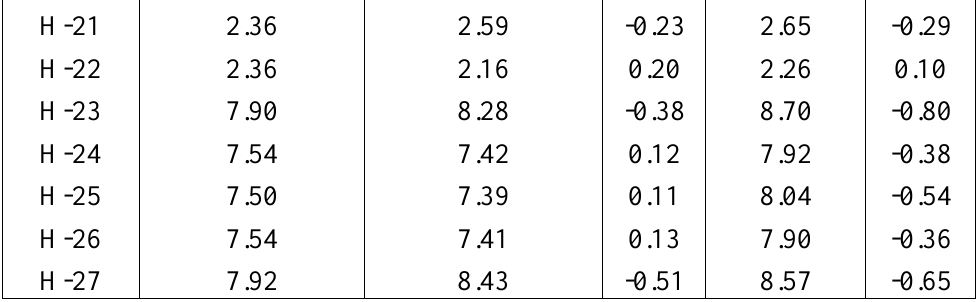
Figure 1. Plot of overall 1 H- and 13 C- data